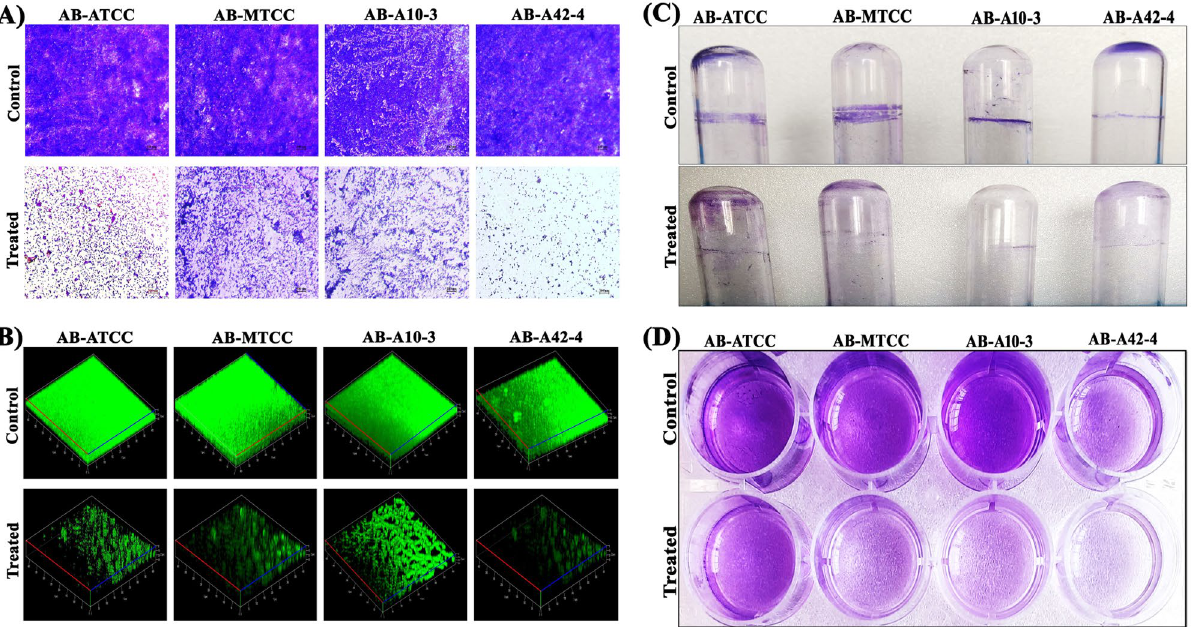
Figure 2. ( A ) Light and ( B ) CLSM images representing the antibiofilm efficacy of myrtenol at 200 μg/mL concentration against AB-ATCC 19606, AB-MTCC 9826, AB-A10-3 and AB-A42-4. Inhibitory potential of myrtenol on ( C ) ring biofilm formation and ( D ) adherence on polystyrene surface by AB-ATCC 19606, AB-MTCC 9826, AB-A10-3 and AB-A42-4.